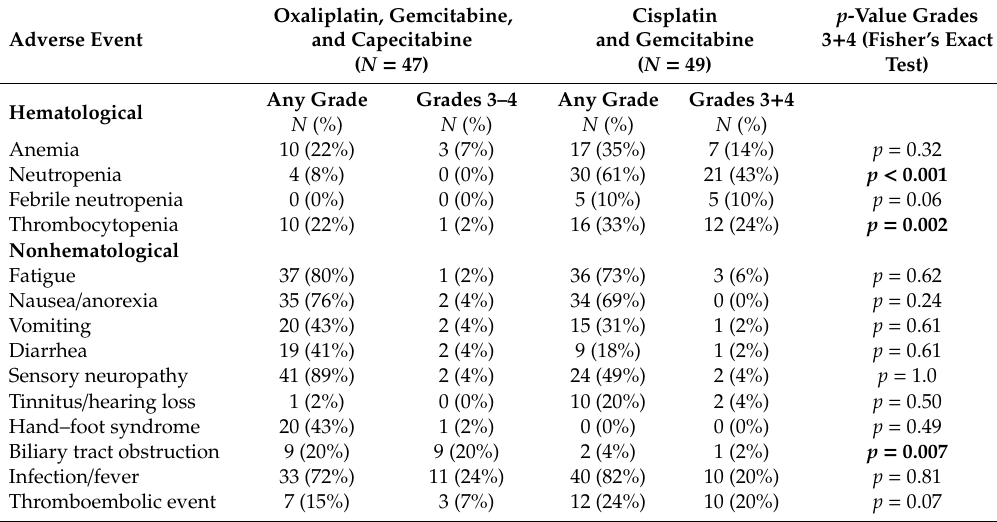
Table 3. Adverse events in the two treatment arms reported as any grade and subdivided as grades 3 and 4. In order to identify statistically significant di ff erences in the toxicity, a Fisher’s exact test was performed on grade 3 and 4 toxicities. Statistically significant values are highlighted in bold.